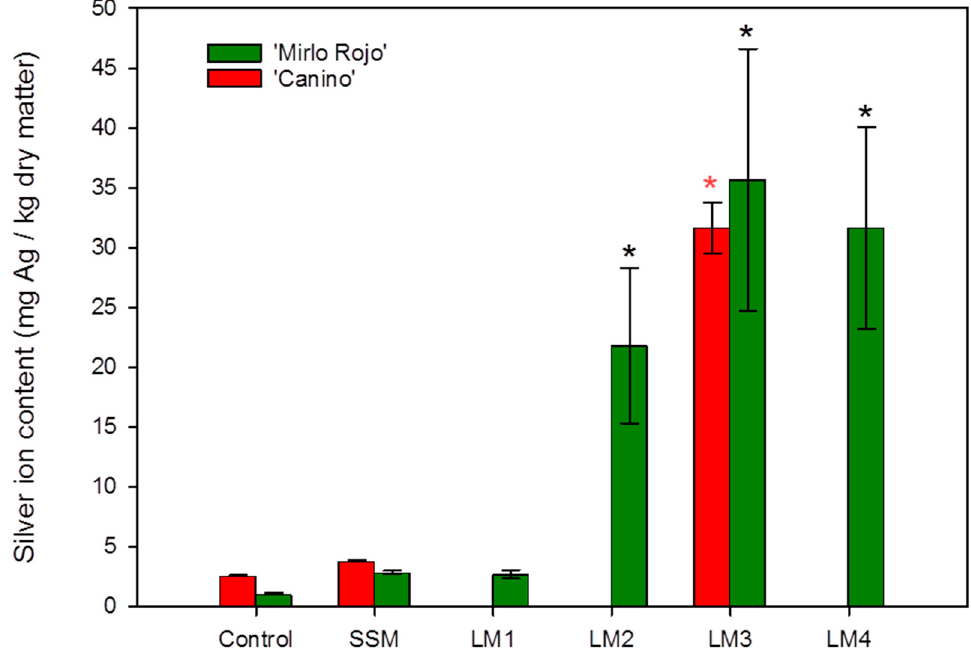
Figure 4. Silver concentration in ‘Mirlo Rojo’ and ‘Canino’ shoots cultured in different media containing 100 mg L − 1 AgNPs. Control medium is SSM without AgNPs. Other media contents are described in Table 1. Bars represent standard errors. Asterisks indicate treatments significantly different from the controls for each cultivar ( p < 0.05) according to a one-tail Dunnett test.